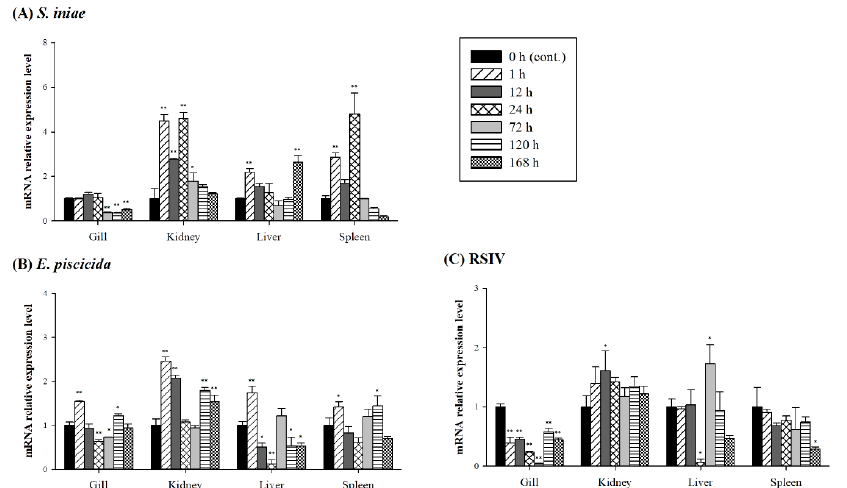
Figure 4. Expression level of PmGal-9 mRNA in the gill, kidney, liver, and spleen of red sea bream after infection with ( A ): Streptococcus iniae , ( B ): Edwardsiella piscicida , or ( C ): red sea bream iridovirus (RSIV). Gene expression levels and their significance are represented as the mean ± SD. Asterisks indicate significant differences (* p < 0.05, ** p < 0.01) versus the control group.